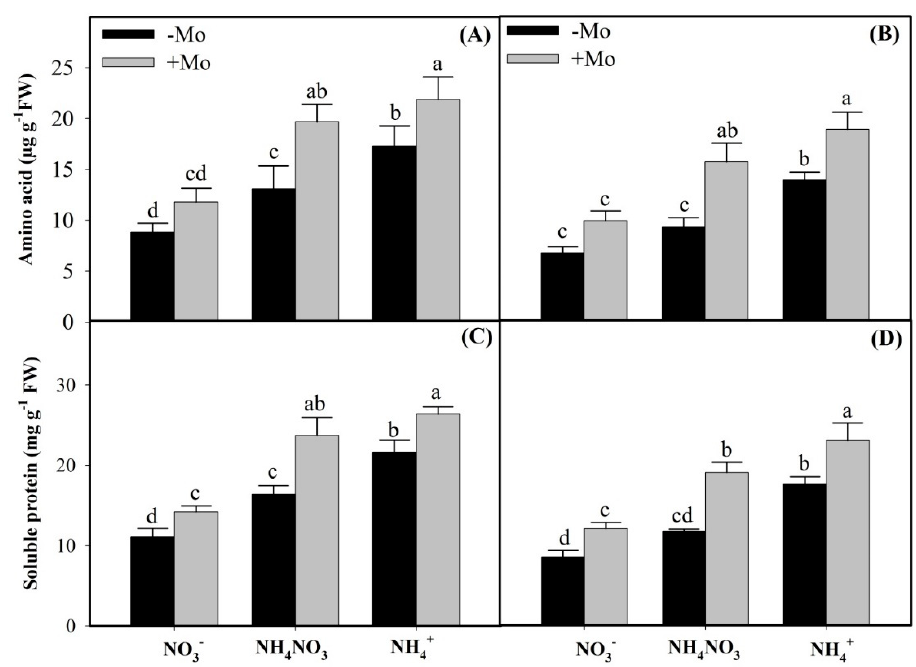
Figure 4. E ff ects of Molybdenum (Mo) application on amino acids and soluble protein contents in leaves of Mo-e ffi cient winter wheat ‘97003’ cultivar ( A , C ) and Mo-ine ffi cient winter wheat ‘97014’ cultivar ( B , D ) under di ff erent N sources. − Mo and + Mo treatments represent 0 and 1 µ M Mo [Na 2 MoO 4 .2H 2 O] concentrations, respectively, in Hoagland solution. Vertical bar above indicates standard error of four replicates. Di ff erent lowercase letters (a, b, c, etc.) represent significant di ff erences according to